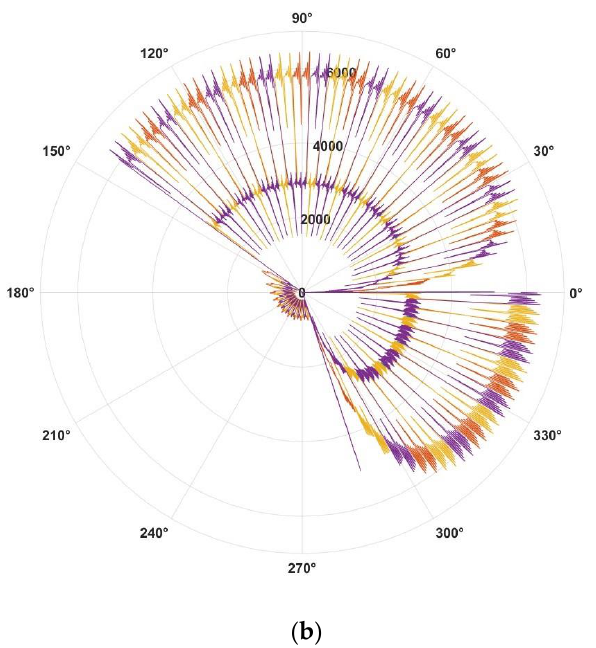
Figure 17. ( a ) Voltage signal during reactor Charging ( b ) Extracted features.